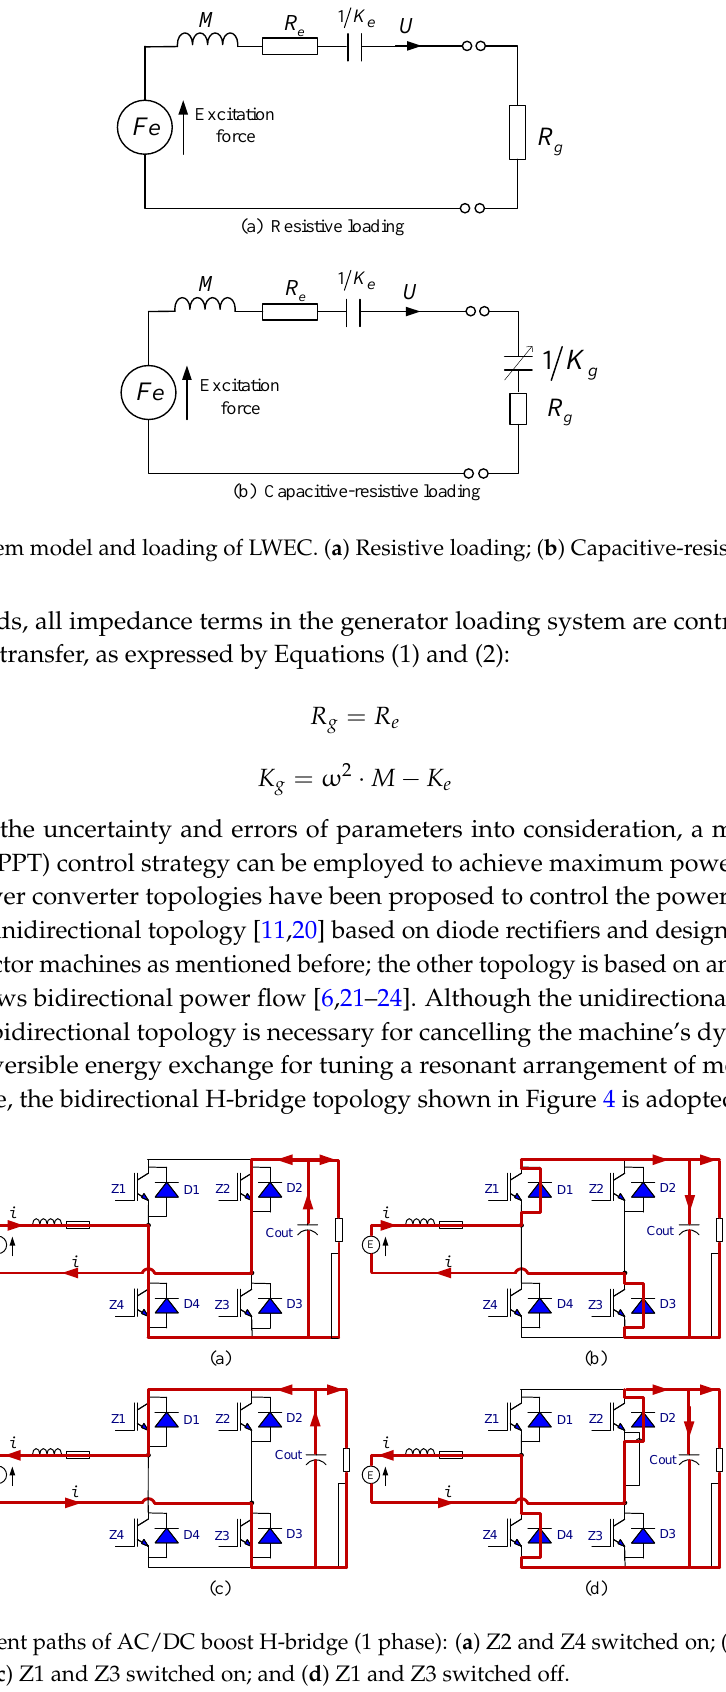
Figure 4. Current paths of AC/DC boost H-bridge (1 phase): ( a ) Z2 and Z4 switched on; ( b ) Z2 and Z4 switched off; ( c ) Z1 and Z3 switched on; and ( d ) Z1 and Z3 switched off.